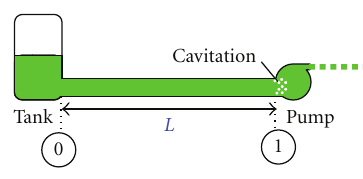
Figure 3: Simple analytical model.